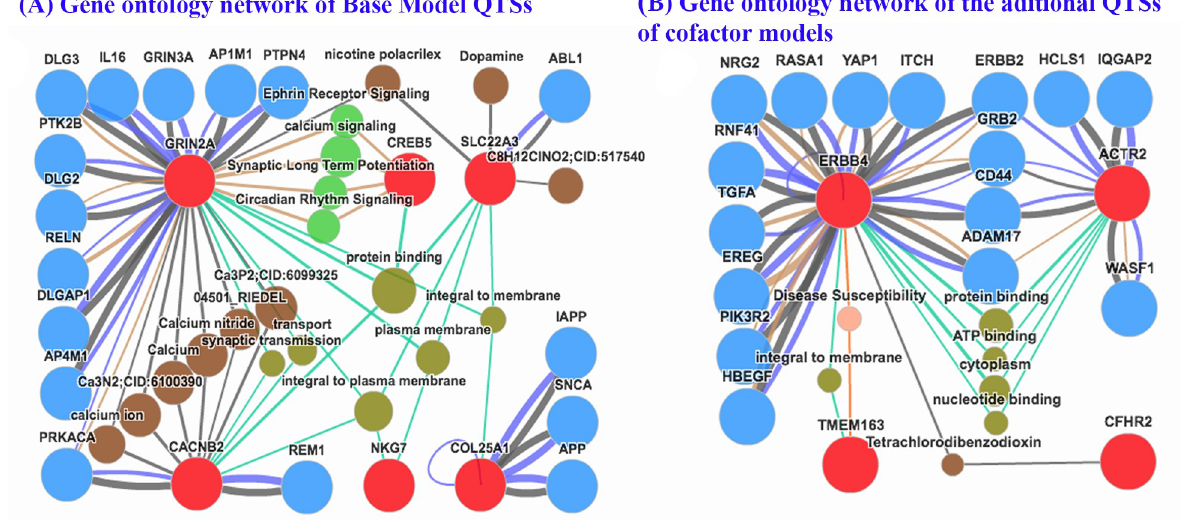
Fig 3. Genetic architecture of detected quantitative trait signal nucleotide polymorphism (QTSs) for BSA. (A) QTSs detected in both the BSA symptom count (non-cofactor) model and individual cofactor models with high significance (– Log 10 P EW > 5); (B) QTSs detected for BSA symptom count only in a suppressed model with high significance (– Log 10 P > 5). The size of balls and thickness of lines stand for a number of publications EW related. Red balls represent seed genes detected; orange balls represent association diseases; Olive balls represent association functions; Brown balls represent association chemicals; Royal blue balls represent association genes. Red-orange lines represent gene-disease association; Paris green lines represent gene ontology; Dark blue lines represent protein-protein interaction; Bronze lines represent pathway interaction; Dark gray lines represent the